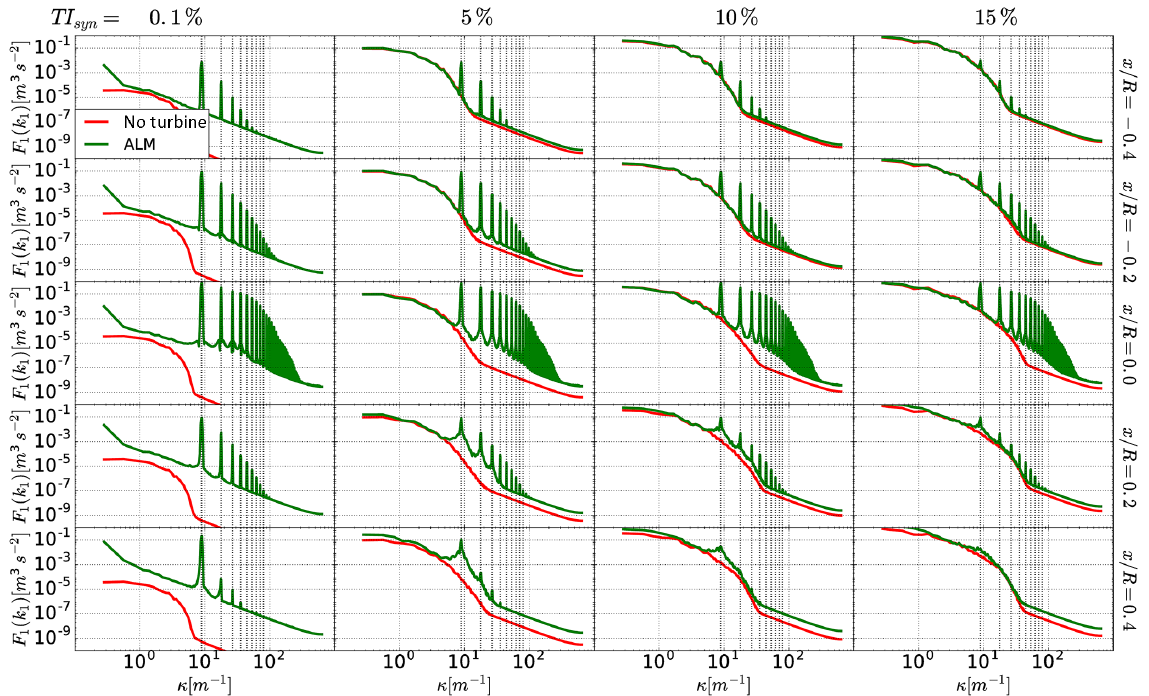
Figure 14. The energy spectra for the HIT based on the time series of the axial velocity component at different points in the near wake ( x/R = {− 0 . 4 , − 0 . 2 , 0 , 0 . 2 , 0 . 4 } ) for different inlet turbulent intensities T syn = { 0 . 1 , 5 , 10 , 15 } % are shown. The impact of the rotor presence can be seen by the spikes at the wavenumber 3 times the rotor frequency and its higher harmonics (dotted black lines).